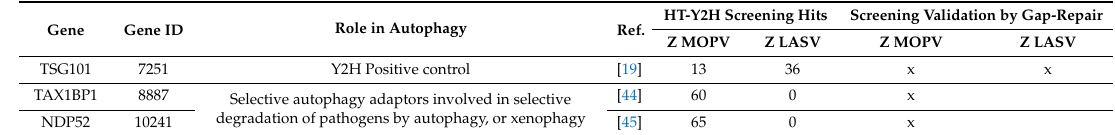
Table 1. Selected “autophagy-linked” host protein interactors of LASV and MOPV Z identified by Y2H and validated by gap-repair. The first and second columns correspond to the canonical gene names and gene IDs, respectively, for the selected interacting cellular proteins. Columns 3 and 4 provide a summarized role of the corresponding protein in autophagy pathways and the reference, respectively. Column 5 shows the number of positive yeast colonies obtained for each cellular protein for the indicated virus Z protein (retrieved from mouse brain, human spleen cDNA libraries and ORFeome). Column 6 shows the results obtained for the validation step by gap-repair in yeast. The “x” indicates the presence of growing colonies for the selected condition. Tsg101 has already been described by others and served as a positive